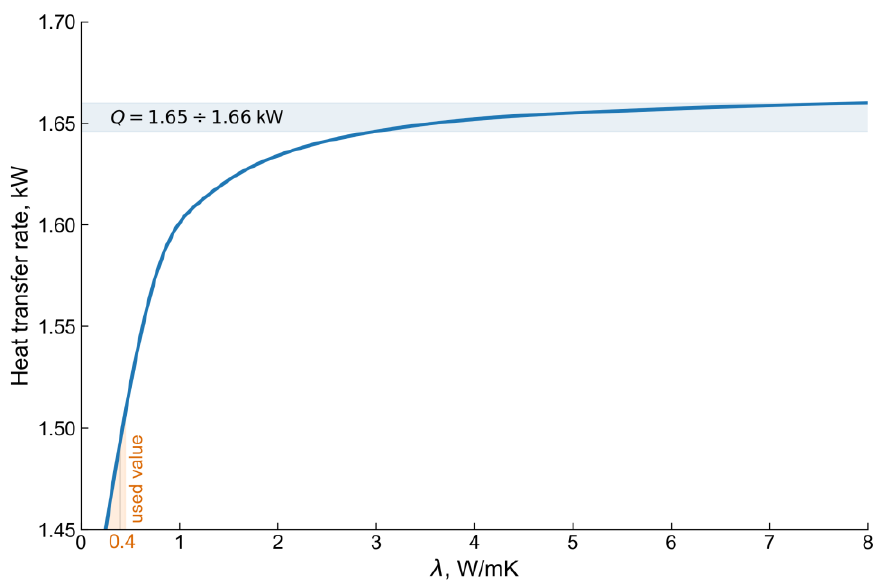
Figure 16. Dependence of the heat transfer rate on the pipe material thermal conductivity.